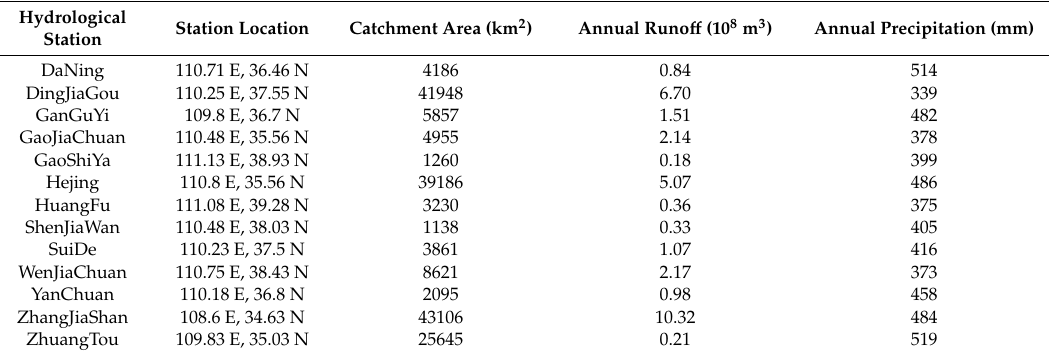
Table 2. Hydrological characteristics of catchments for model